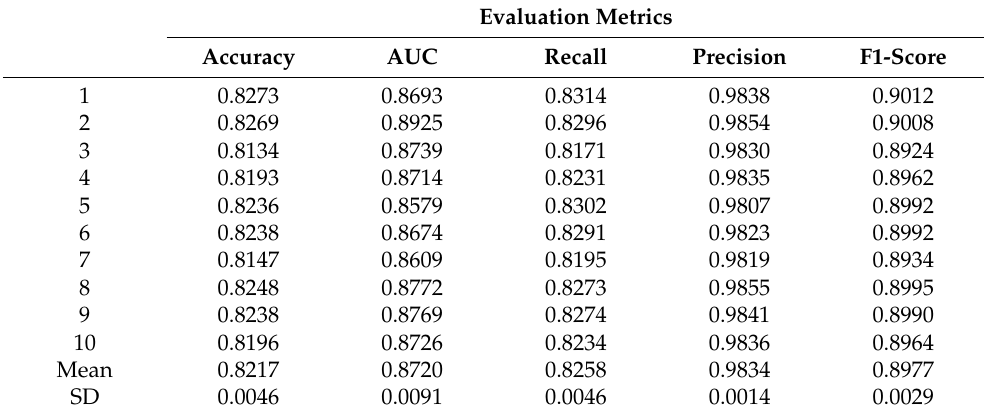
Table 6. The 10-fold cross-validation results for